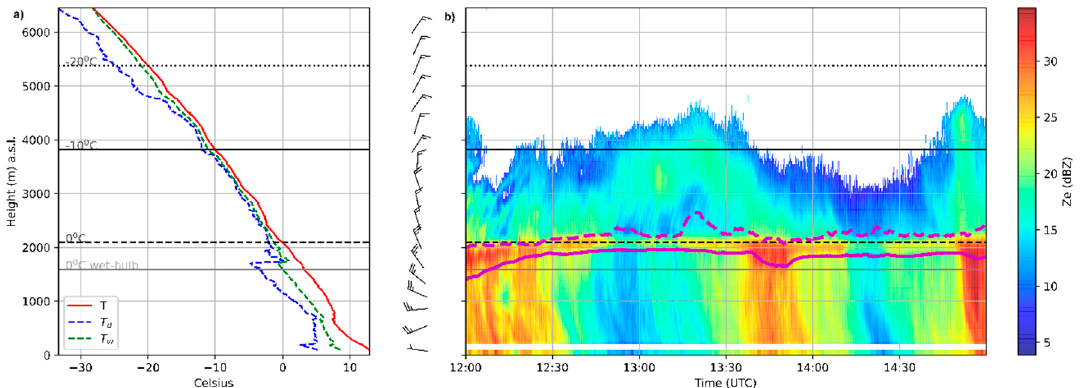
Figure 10. ( a ). Sounding profiles of dry-bulb ( T ), wet-bulb ( T w ) and dew point ( T d ) temperatures, also showing the 0 ◦ C, − 10 ◦ C, − 20 ◦ C dry-bulb and 0 ◦ C wet-bulb temperature levels and the wind profile, corresponding to 31 March 2020 12 UTC, ( b ). Radar equivalent reflectivity time–height display from MRR- Pro and Parsivel observations, the latter is plotted at the low height level, from 12 to 15 UTC 31 March 2020.